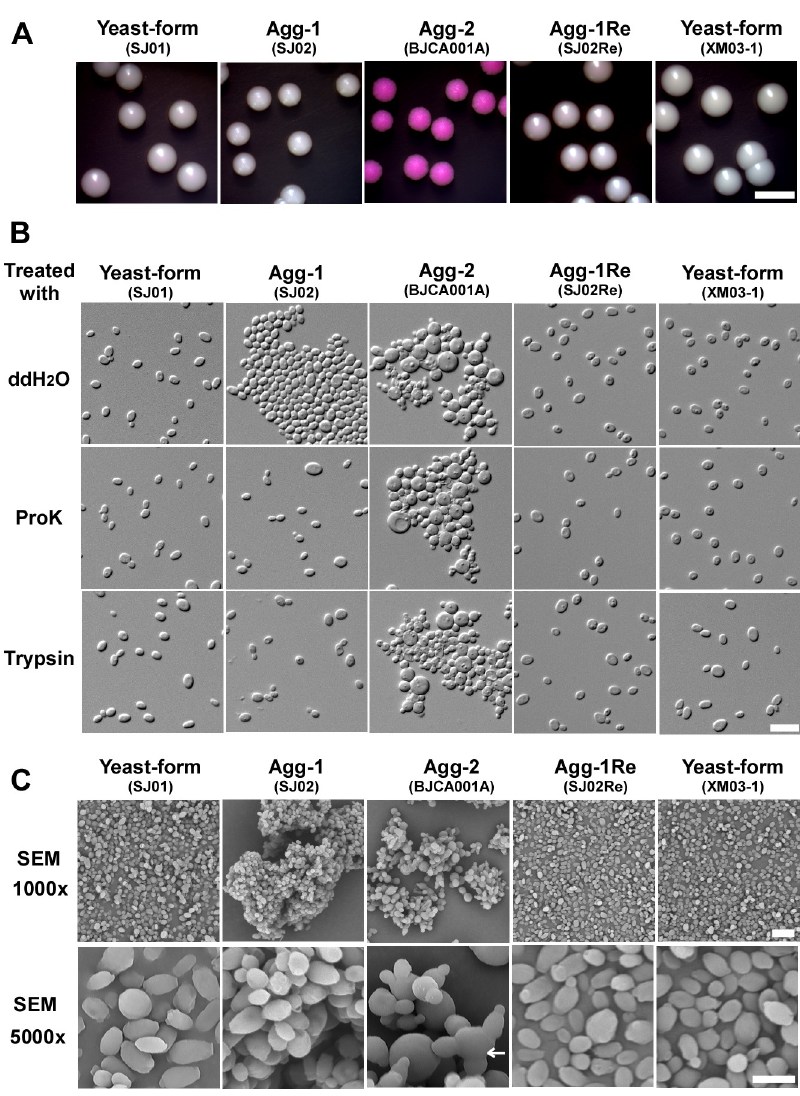
Fig 1. Colony and cellular morphologies of the nonaggregative/yeast-form (SJ01), Agg-1 (SJ02), Agg-2 (BJCA001A), Agg-1Re (SJ02Re), and XM03-1 strains of C . auris . Strains SJ01 and SJ02 were isolated from the same patient. BJCA001A is the aggregating form of strain BJCA001. The nonaggregative/yeast-form strain SJ02Re was spontaneously generated form cells of strain SJ02 grown on YPD medium. Strain SJ02Re carries a single copy of ALS4 . Strain XM03-1 is a clinical isolate that is missing ALS4 . (A) Colony morphologies. C . auris cells were plated on YPD medium containing 5 μ g/mL phloxine B for 4 days at 30˚C. Scale bar = 5 mm. (B) DIC images of C . auris cells treated with ddH 2 O, proteinase K, or trypsin. C . auris cells of a single colony of each strain were washed with 1 x PBS and then treated with ddH 2 O, proteinase K, or trypsin for 1 hour at 37˚C. Scale bars,10 μ m. (C) Low and high magnification SEM images of C . auris cells. The culture condition was the same as used in panel A. Scale bar,10 μ m. Strains SJ02Re and XM03-1 served as